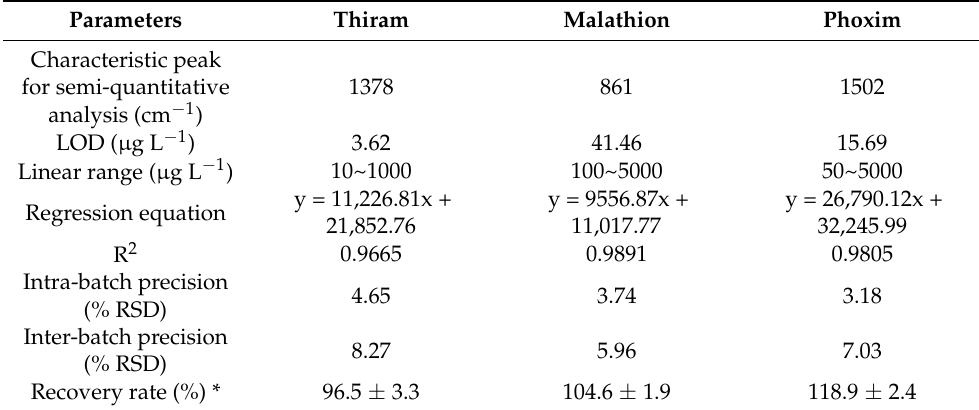
Table 2. Summary of validation parameters of the proposed method.